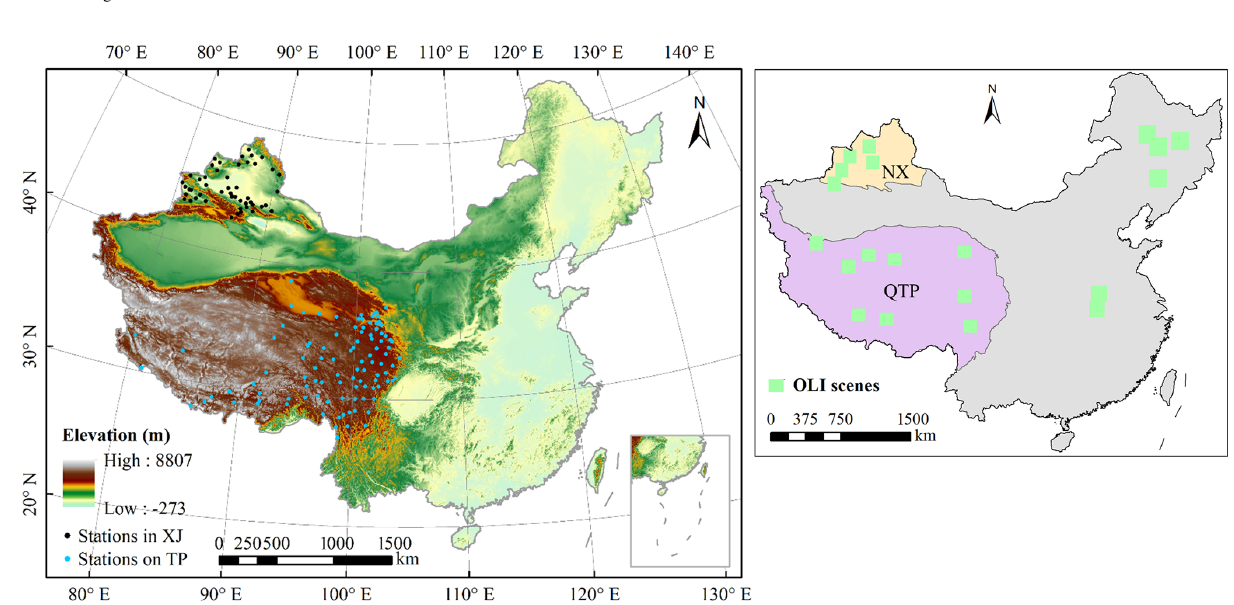
Figure 1. Topographic relief of China, meteorological stations in NX and QTP, and Landsat OLI scenes used for validation.